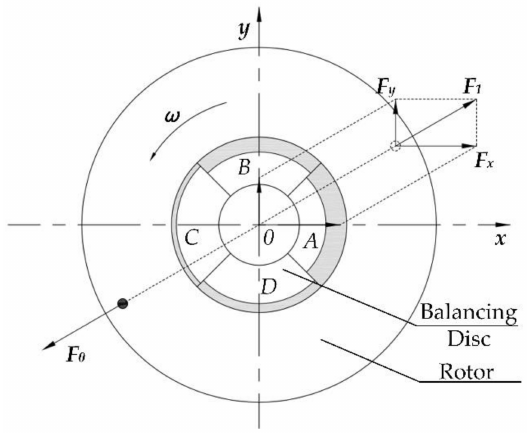
Figure 3. Balancing principle of the